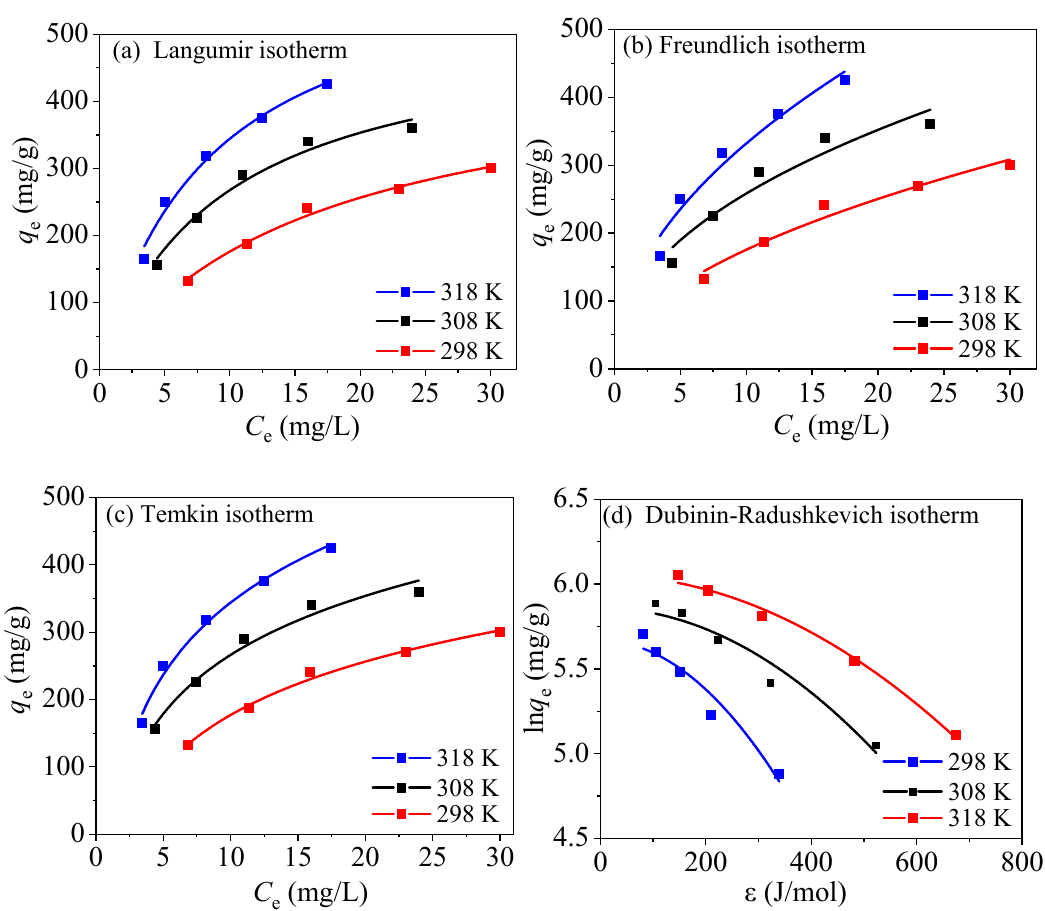
Figure 12. Fitting results of isotherm adsorption with PPy-Fe 3 O 4 / Kaolin. Table 3. Adsorption isotherm parameters of PPy-Fe 3 O 4 /Kaolin. Langmuir